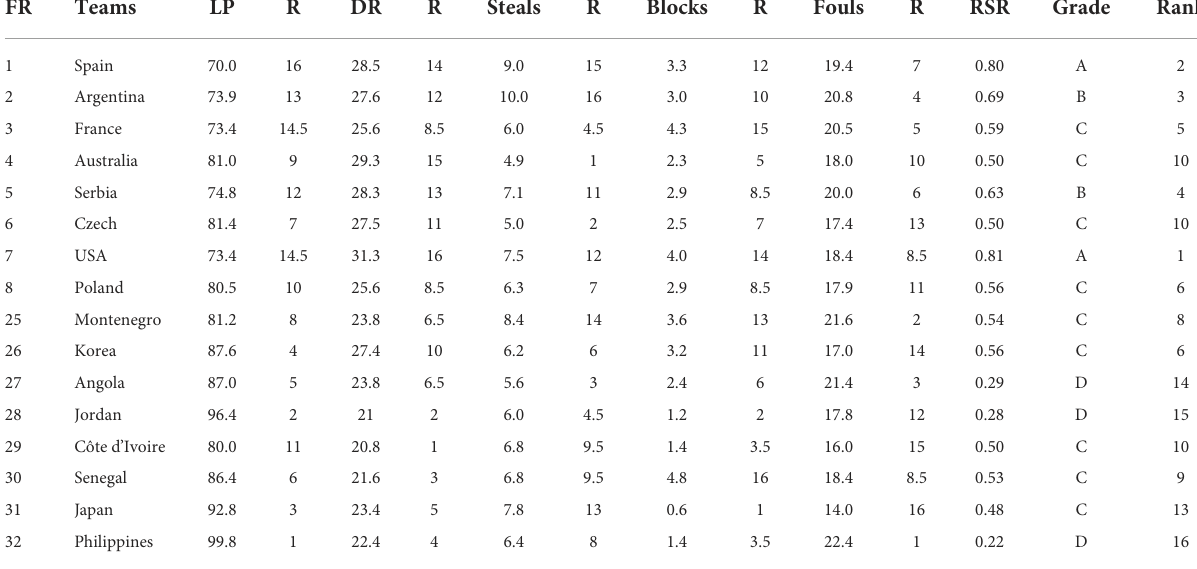
indicators between the top eight and bottom eight teams, including points, 2P%, 3P%, FT%, second chance points, fast- break points, offensive rebounds, assists, turnovers, lose points, defensive rebounds, steals, blocks, and fouls. The data shown in Table 4 are the average data for each team. The top eight teams were far better than the bottom eight teams in terms of average points, 2P %, 3P%, FT%, assists,